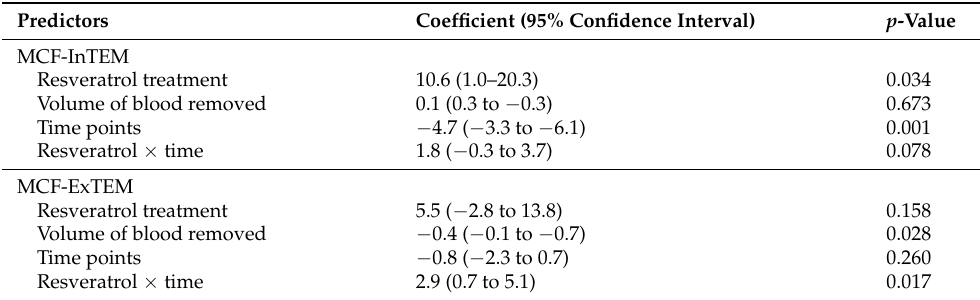
Table 6. Linear mixed models showing the associations between resveratrol treatment with maximum clot firmness on the Rotational Thromboelastometry (ROTEM ® ) of the anesthetized greyhound dogs before and after induced hemorrhage ( n = 12) after adjusting for volume of blood removed using unstructured covariance structure. MCF = maximum clot